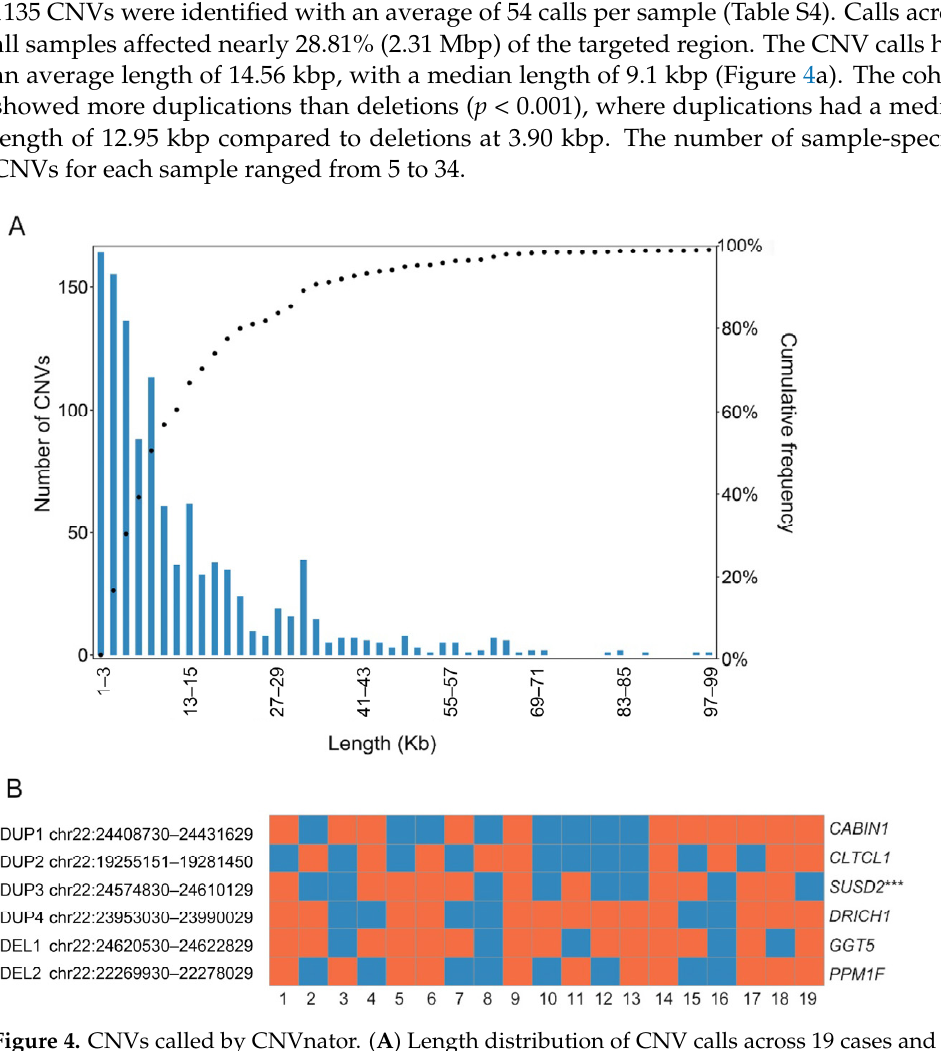
Figure 4. CNVs called by CNVnator. ( A ) Length distribution of CNV calls across 19 cases and the healthy parents. ( B ) Distribution of candidate CNVs in 19 cases. The presence of a particular copy number variation (CNV) in the patient is indicated by red, and its absence is indicated by blue. *** p < 0.001 in